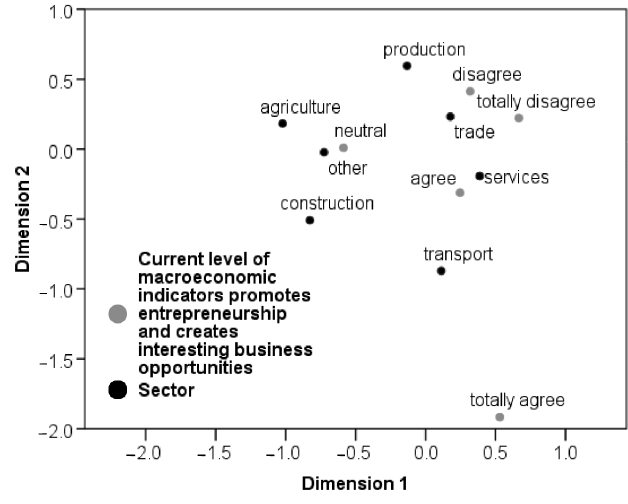
Figure 12. Correspondence analysis/the Czech